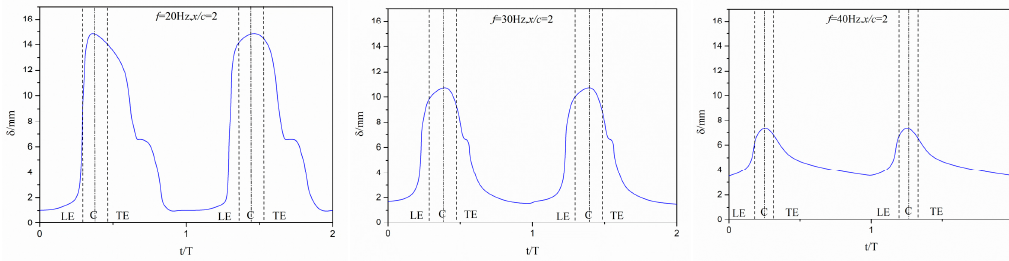
Figure 15. Boundary layer thickness 𝛿 (cid:2877)(cid:2877) variation in two periods at different RSI frequency.